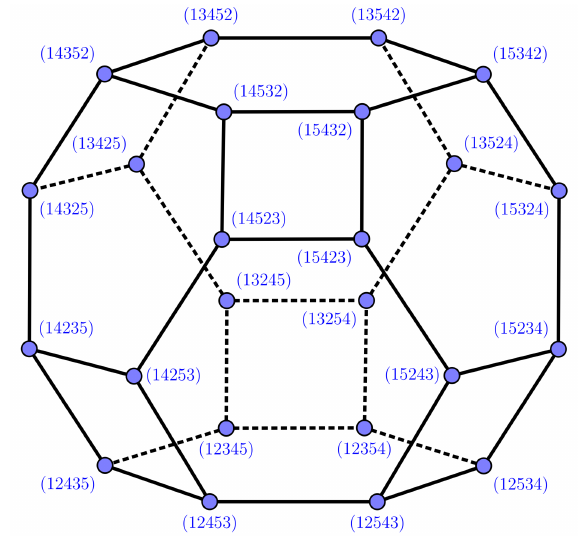
Figure 9 . The permutohedron of order 4 is dual to the complete fan of positive sectors for G + (2 , 5) .